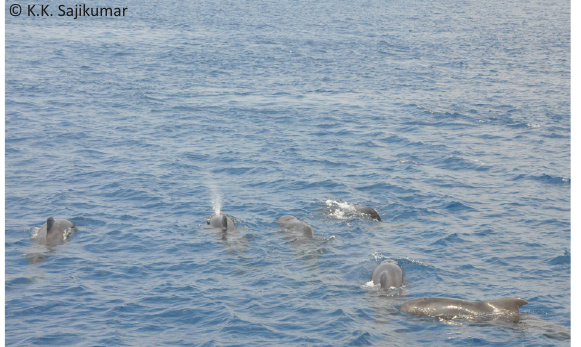
Image 3. The whale piloting the vessel.